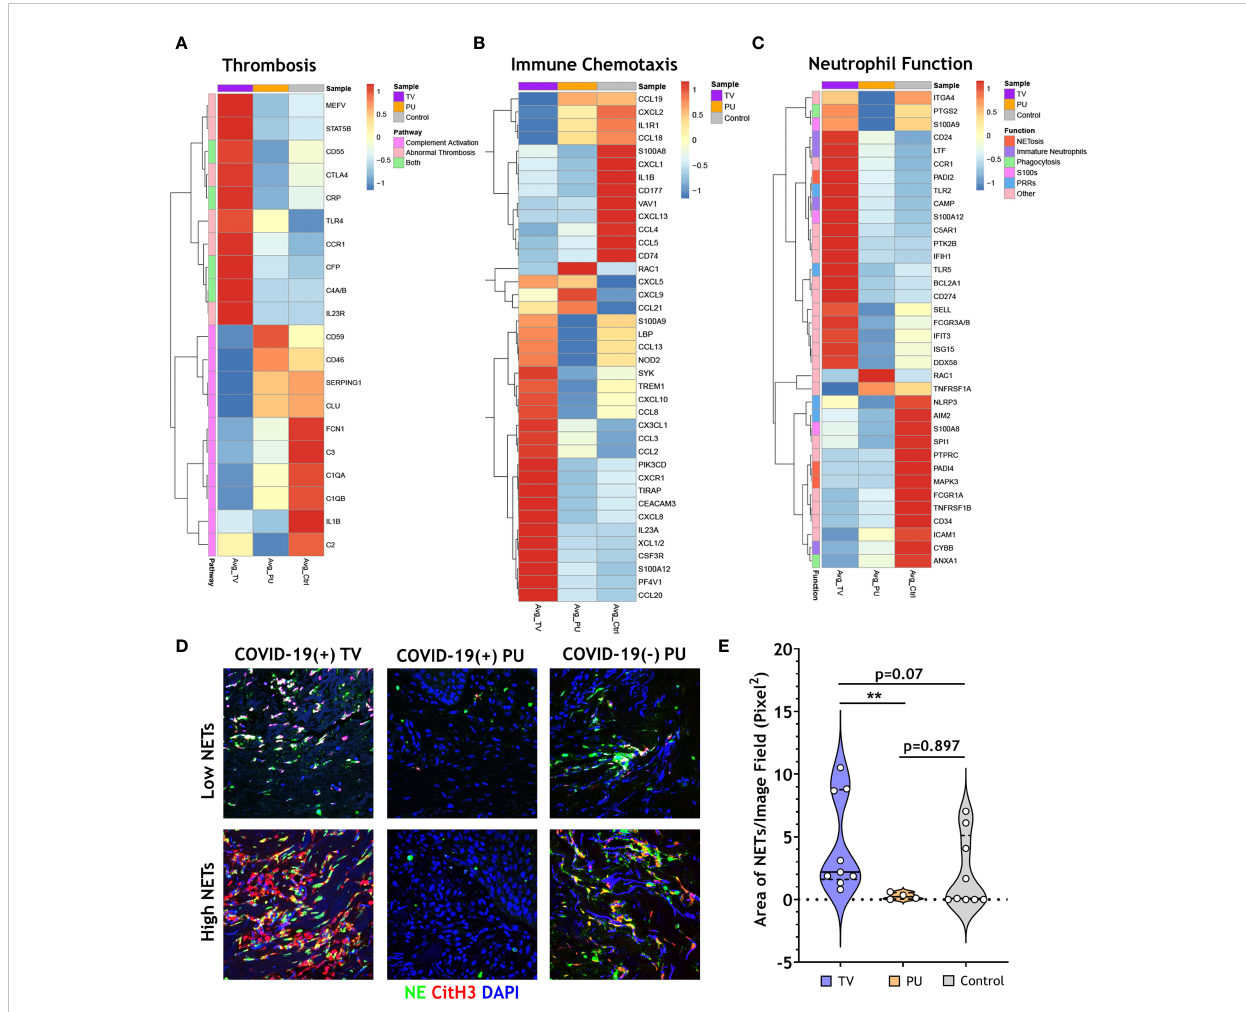
FIGURE 4 COVID-19 thrombotic vasculopathy is characterized by abnormal thrombosis and neutrophil extracellular trap formation. (A) Clustered heatmap shows the average normalized counts of genes involved in thrombosis and complement activation for COVID-19(+) TV (TV) and COVID-19(+) PU (PU) samples compared to COVID-19(-) PU (Control). Pathway speci fi c genes were selected based on GO biological pathways. (B) Clustered heatmap illustrates the average normalized counts of genes involved in immune cell chemotaxis and extravasation for COVID-19(+)TV and PU samples compared to COVID-19(-) PU Controls. Genes were selected based on GO biological pathways. (C) Neutrophil speci fi c genes arranged by function (NETosis, Immature Neutrophils, Phagocytosis, S100s, PRRs, or Other) represented in a clustered heatmap comparing the average normalized counts of DEGs in COVID-19(+) TV and PU groups relative to COVID-19(-) PU Controls. (D) Immuno fl uorescence staining of NETs in skin tissue sections. Markers of NETs used include NE (green), CitH3 (red) and nuclei (blue). Images acquired using confocal microscopy, 40X oil objective (E) Quanti fi cation of tissue NETs in the skin using Image J